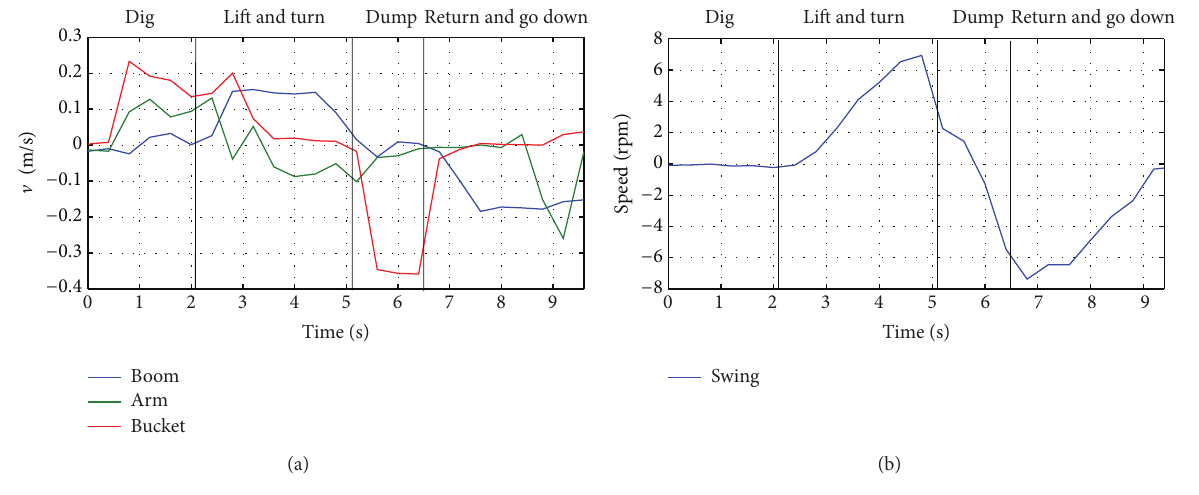
Figure 3: The velocity of the actuator during the working cycle.